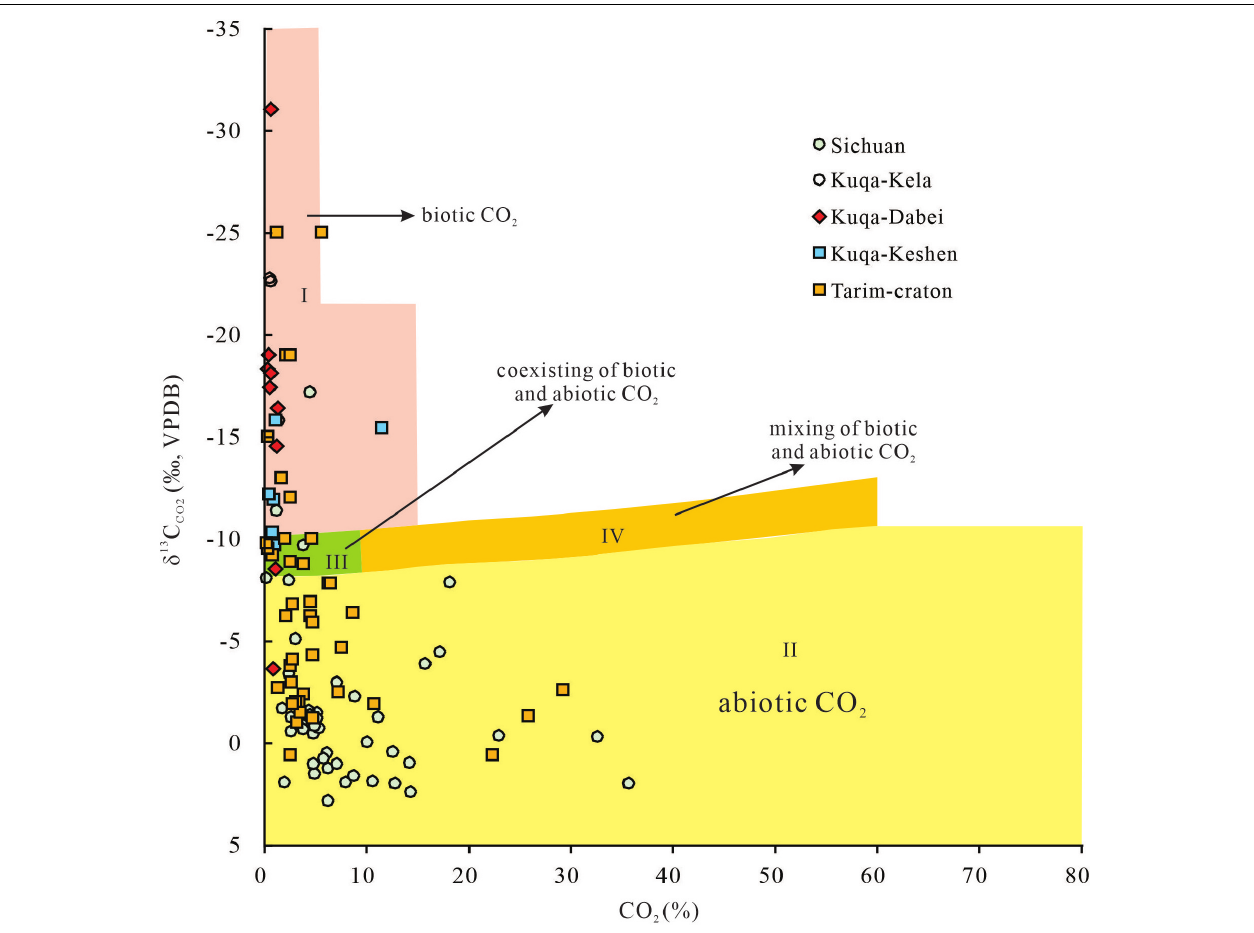
FIGURE 10 | Plot of δ 13 C CO2 vs. CO 2 of gases from Dabei, Keshen and Kela2 gas fields in the Kuqa depression, craton area of Tarim Basin and Sichuan Basin, distinguishing the origin of CO 2 (Dai et al., 1992). Data source see section “Samples and Methods” in the